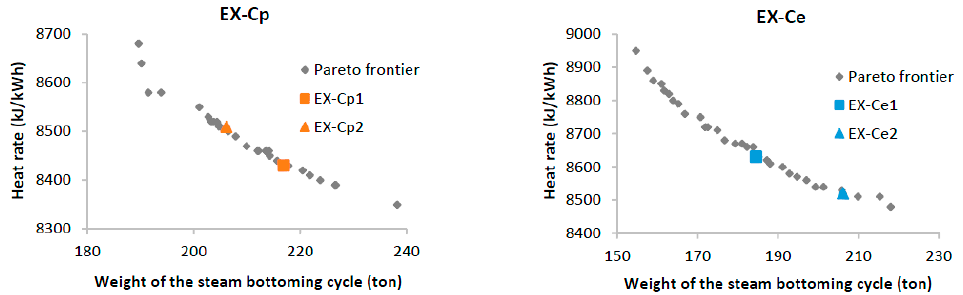
Figure A5. Pareto frontiers of extraction steam turbine cycle for case C at peak (EX-Cp) and end-life (EX-Ce) conditions. Energies 2017 , 10 , 744